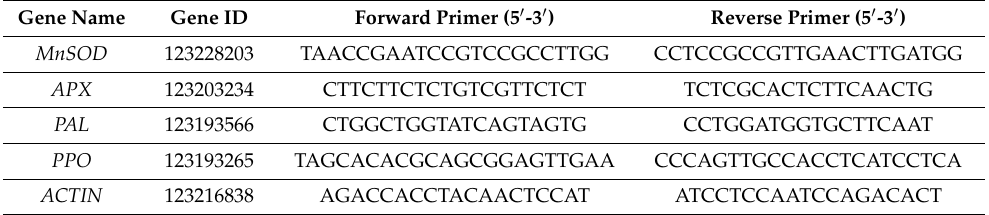
Table 1. The sequences of specific primers used for qRT-PCR quantification.